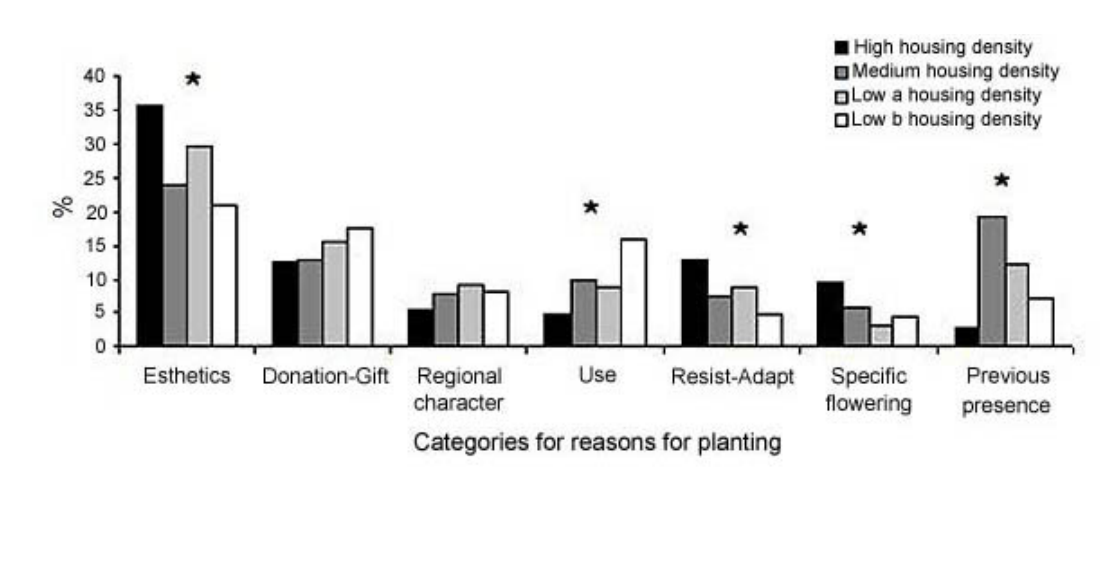
Fig. 5. Frequency distribution of categories for reasons given for planting of common species by housing density zones (* 95% confidence